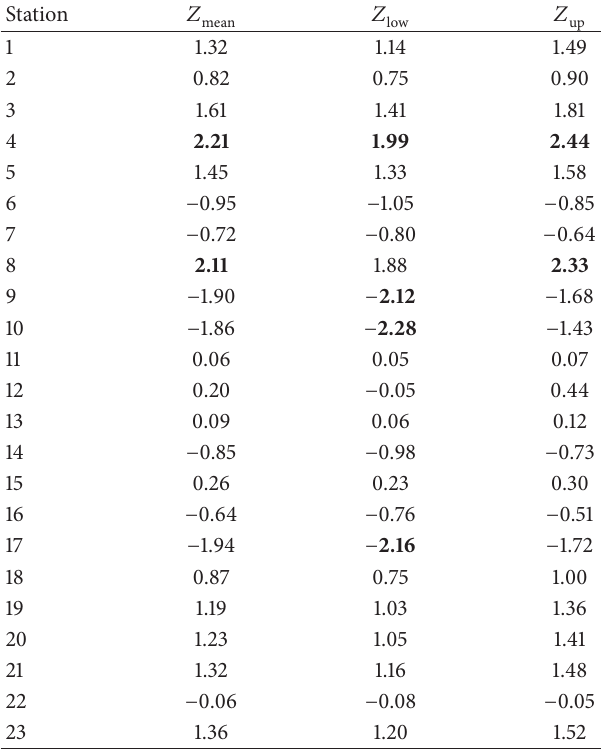
Table 3: Uncertainty in trend directions due to the differences among